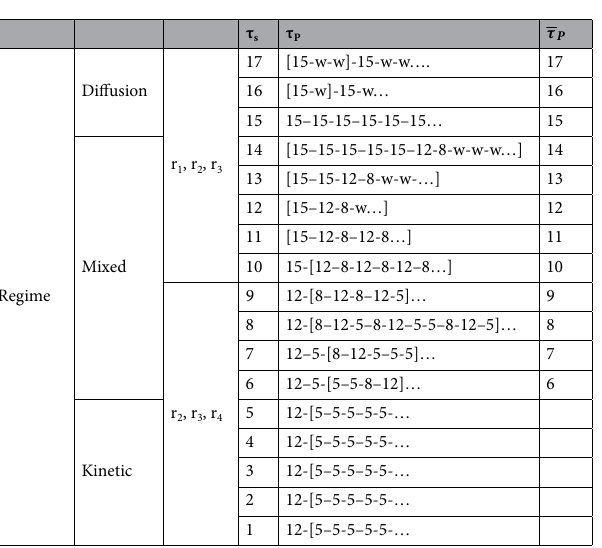
Table 1. All possible regimes of the cluster operation in the case of arbitrary selected numerical example: τ s is the supply time, τ P is the period between two successive releases of P, τ P is the averaged value, τ 1 = 15, τ 2 = 12, τ 3 = 8 , τ 4 = 5 (beats), r i are routs on the